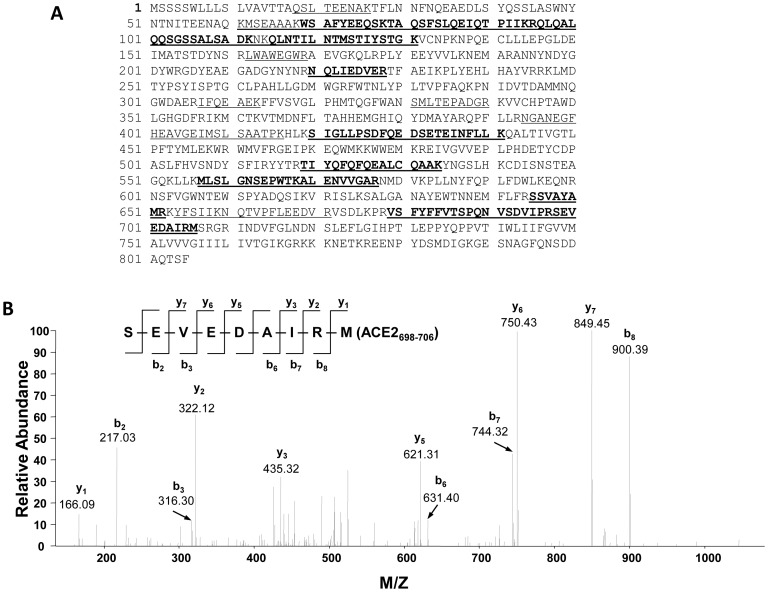
Identification of ACE2 peptides by LC-MS/MS in the 75 kDa deglycosylated band from the media of mouse PT cells.(A) Mass spectrometry identified peptides matched with the mouse ACE2 sequence (SWISS-PROT database no. Q8R0I0) at positions 18-706. The identified peptide sequences significantly matched with mouse ACE2 precursor in the database are underlined and shown in bold. The peptides matched with mouse ACE2 sequence, but not statistically significant, are underlined only (see Table S2 for detailed analyses of peptides). The overall matched sequences cover 32% of mouse ACE2 sequences. (B) Tandem mass spectrum of the C-terminal peptide (SEVEDAIRM 698–706). The b and y ions result from the cleavage of peptide bonds and correspond to N-terminal and C-terminal fragments of the peptide, respectively. The detected b and y ions are consistent with the peptide sequence shown on the top part of the panel. Ions score: 50, Observed ion: 533.25, Mr(expt): 1064.48, Mr(calc): 1064.48. Expect value: 0.002 (see Table S2 for details). The amino acid Met706 detected is from non-tryptic cleavage, suggesting a cleavage site for the ectodomain shedding of mouse ACE2 into the media.